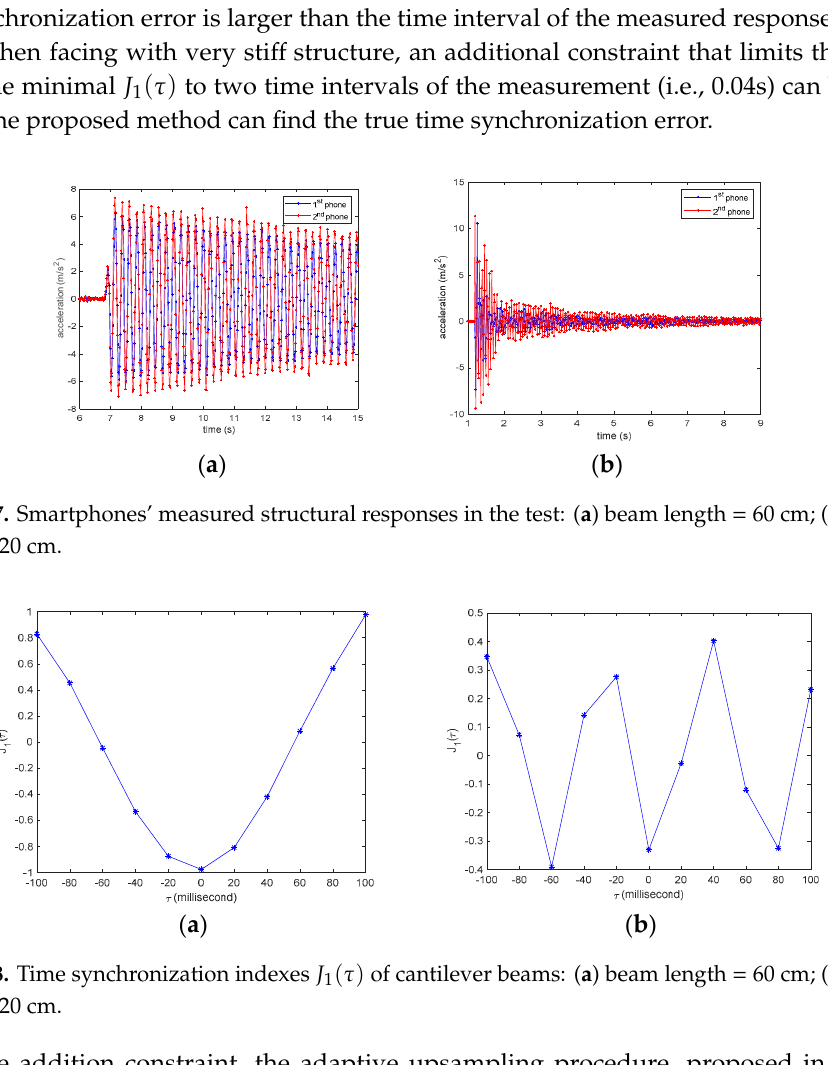
Figure 16. Setup of test.